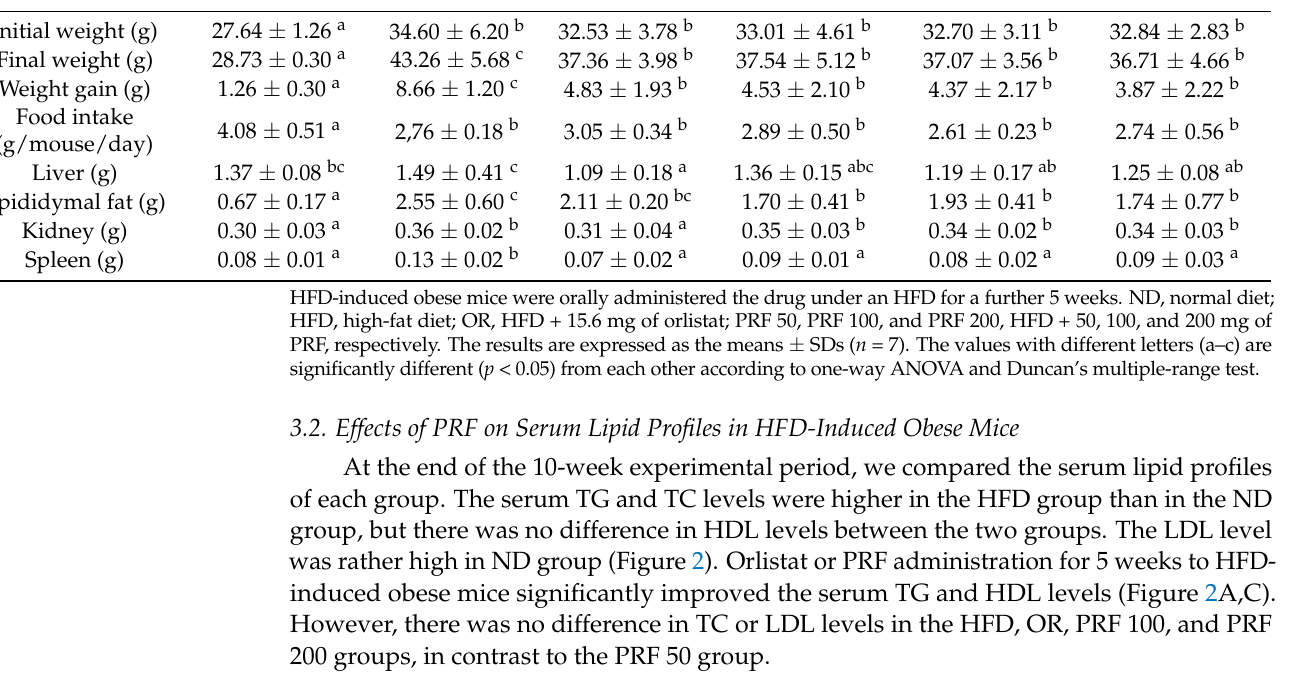
Table 1. Effects of PRF on body weight food intake and organ weights in HFD-induced obese mice. ND HFD OR PRF 50 PRF